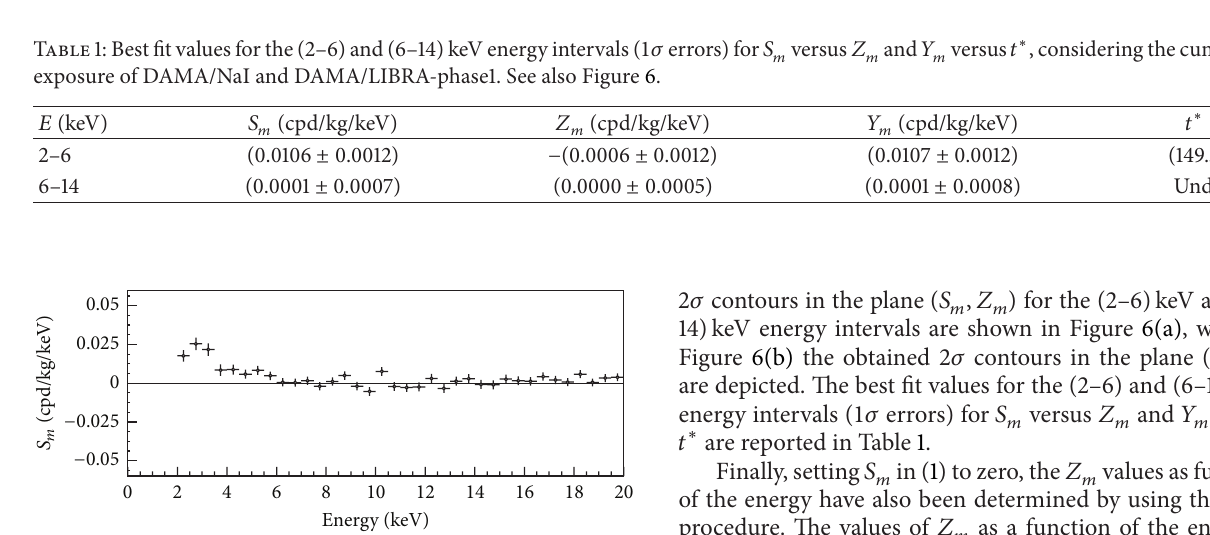
Figure 5: 𝑆 𝑚 variable as a function of the energy for the total cumulative exposure 1.33 ton × yr. The energy bin is 0.5 keV. A clear modulation is present in the lowest energy region, while 𝑆 𝑚 values compatible with zero are present just above. In fact, the 𝑆 𝑚 values in the (6–20)keV energy interval have random fluctuations around zero with 𝜒 2 equal to 35.8 for 28 degrees of freedom (upper tail probability of